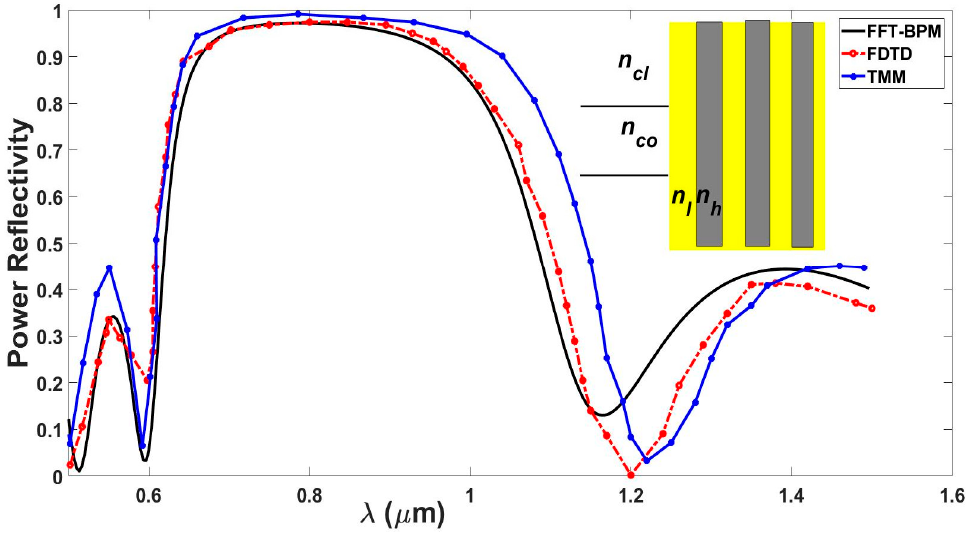
Figure 4. The power reflectivity as function of the wavelength of a multilayer coating made of 6 layers each having a thickness λ /4.